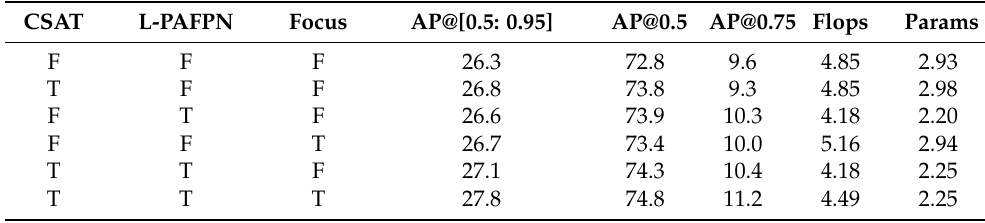
Table 8. Ablation experiment on the